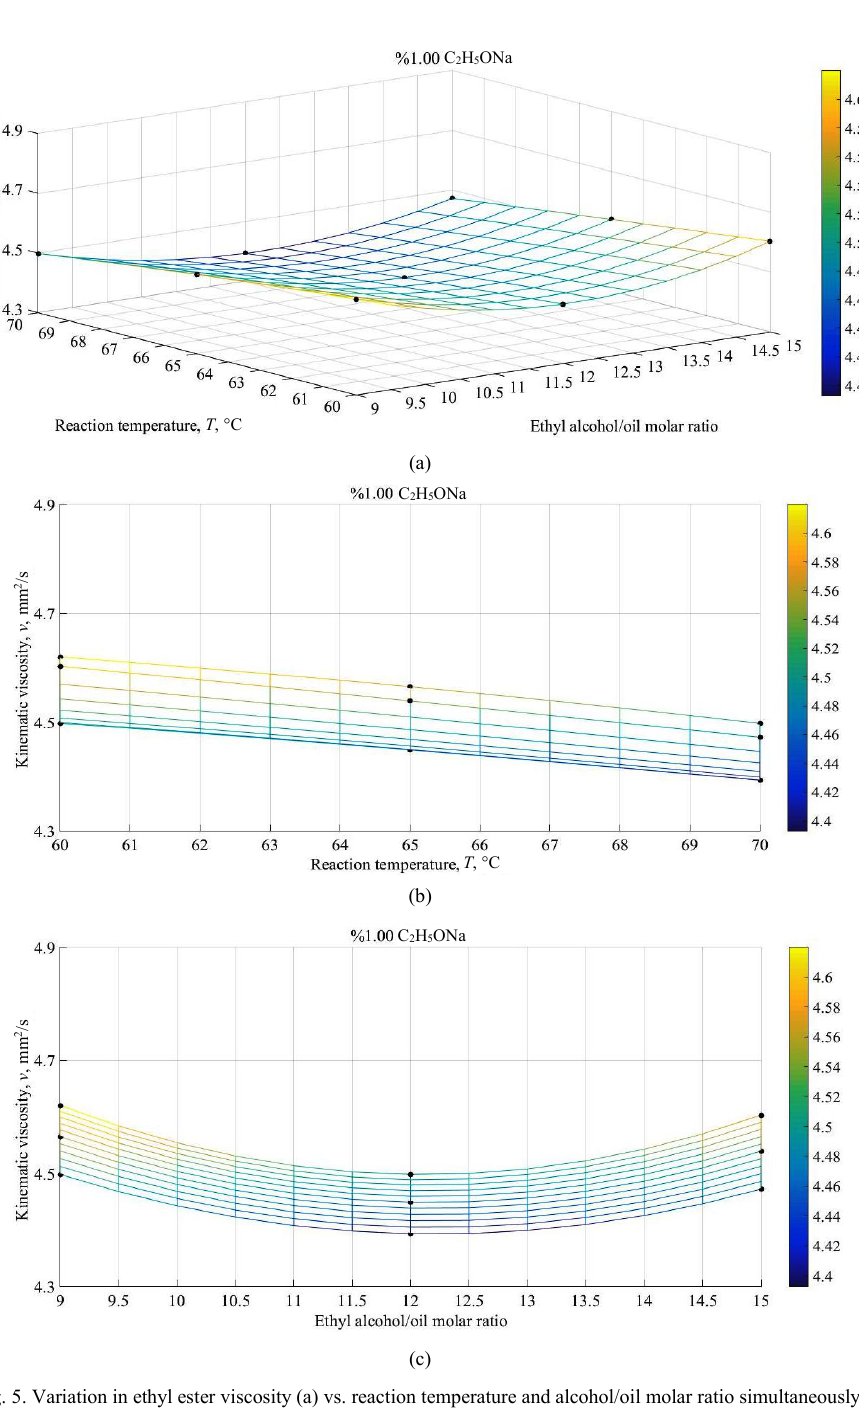
Fig. 5. Variation in ethyl ester viscosity (a) vs. reaction temperature and alcohol/oil molar ratio simultaneously; (b) alcohol/oil molar ratio; (c) reaction temperature for the catalyst concentration of 1.00